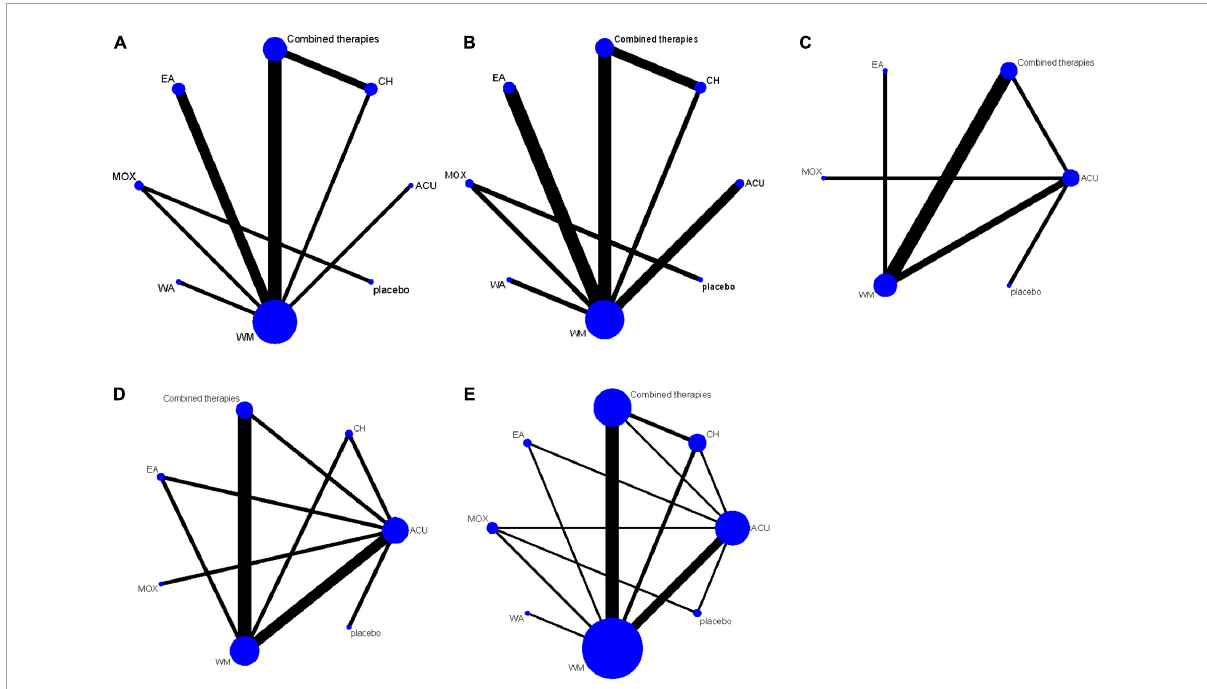
FIGURE3 The network structure for treatment comparisons. (A) SAS scores; (B) SDS scores; (C) HAMA scores; (D) HAMD scores; (E) response rate. ACU, acupuncture; EA, electroacupuncture; MOX, moxibustion; CH, Chinese herb medicine; WA, warm acupuncture; combined therapies, the combination of acupuncture-related therapies and other therapies; WM, western medicine of anti-diarrheal or anti-spasmodic; placebo, and placebo acupuncture/blank